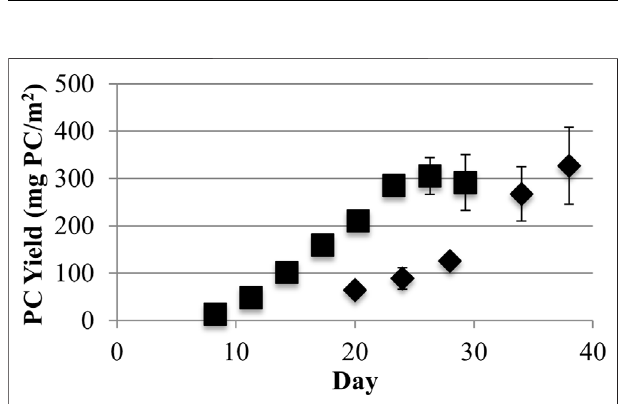
FIGURE 4 | Growth surface area yields of phycocyanin (PC) from low (40) ( ◆ ) and high (220) ( ■ ) light ( μ mol photons m − 2 s − 1 PAR) conditions (one standard deviation shown, n ≥